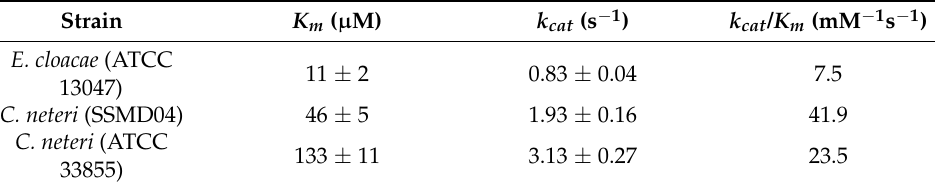
Table 1. Kinetic parameters ( K m and k cat ) of the purified rAmpC enzymes from E. cloacae (ATCC